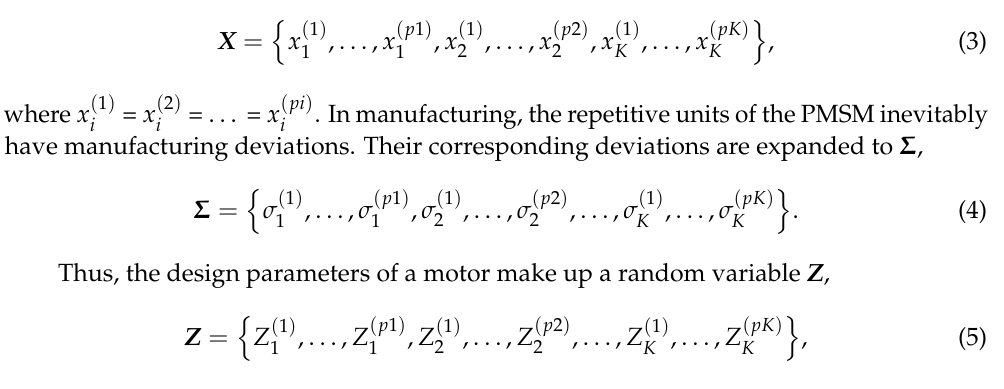
Figure 3. Repetitive units of the permanent magnet synchronous motor (PMSM). Consider a motor with K design parameters that has center value x = { x 1 , x 2 , . . . , x K }, where the deviations between actual design parameters and ideal center values can be presented as σ = { σ 1 , σ 2 , . . . , σ K }, and the number of repetitive units of the k th design parameter is p k . Then, for convenience of expression, the center value after taking repetitive units into account can be expanded to X